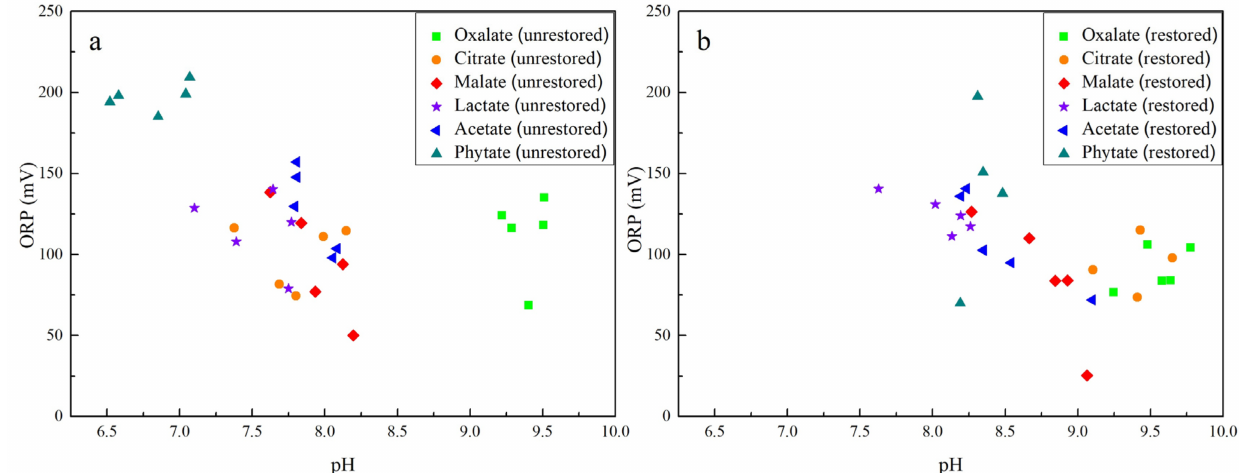
Figure 4. Soil pH and ORP distribution under biotic conditions with different LMWOAS amendments in unrestored ( a ) and restored ( b ) soils.